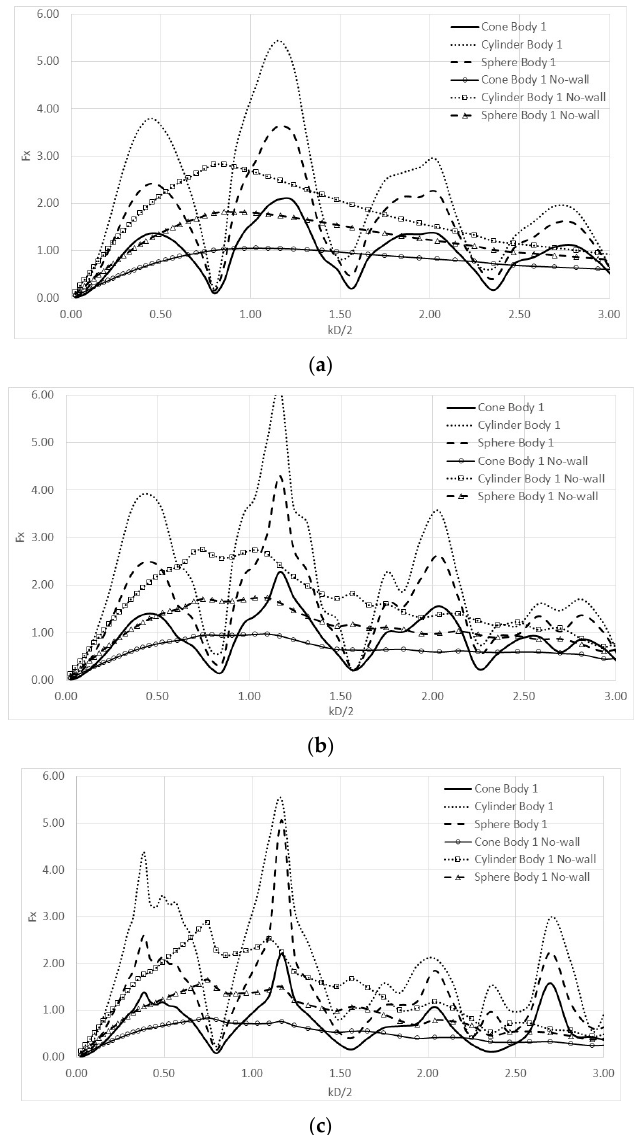
Figure 7. Dimensionless horizontal exciting wave forces acting on the 1st floater of the arrays against kD/2, for the three different examined array configurations. Comparison with the surge exciting wave forces on the same floater of the arrays without the presence of the breakwater: ( a ) parallel arrangement, C 1 ; ( b ) rectangular arrangement, C 2 ; ( c ) perpendicular arrangement, C 3 . Moreover, it is also depicted that the horizontal exciting forces on the 1st cylinder of the cylindrical floater array are larger comparing with those on the conical and the semi-spherical floater-array. The reason is the volume of the cylindrical floater which is larger than the volume of the semi-spherical and the conical floater. Finally, it can be seen from the Figure 7b,c, that the scattered waves between the remaining bodies of the perpendicular and rectangular arrangement and the examined floater, create additional peaks (i.e., at kD/2 ≈ 0.6; 1.7; 2.4) on the horizontal forces compared with the corresponding values on the 1st floater of the parallel arrangement. This can be